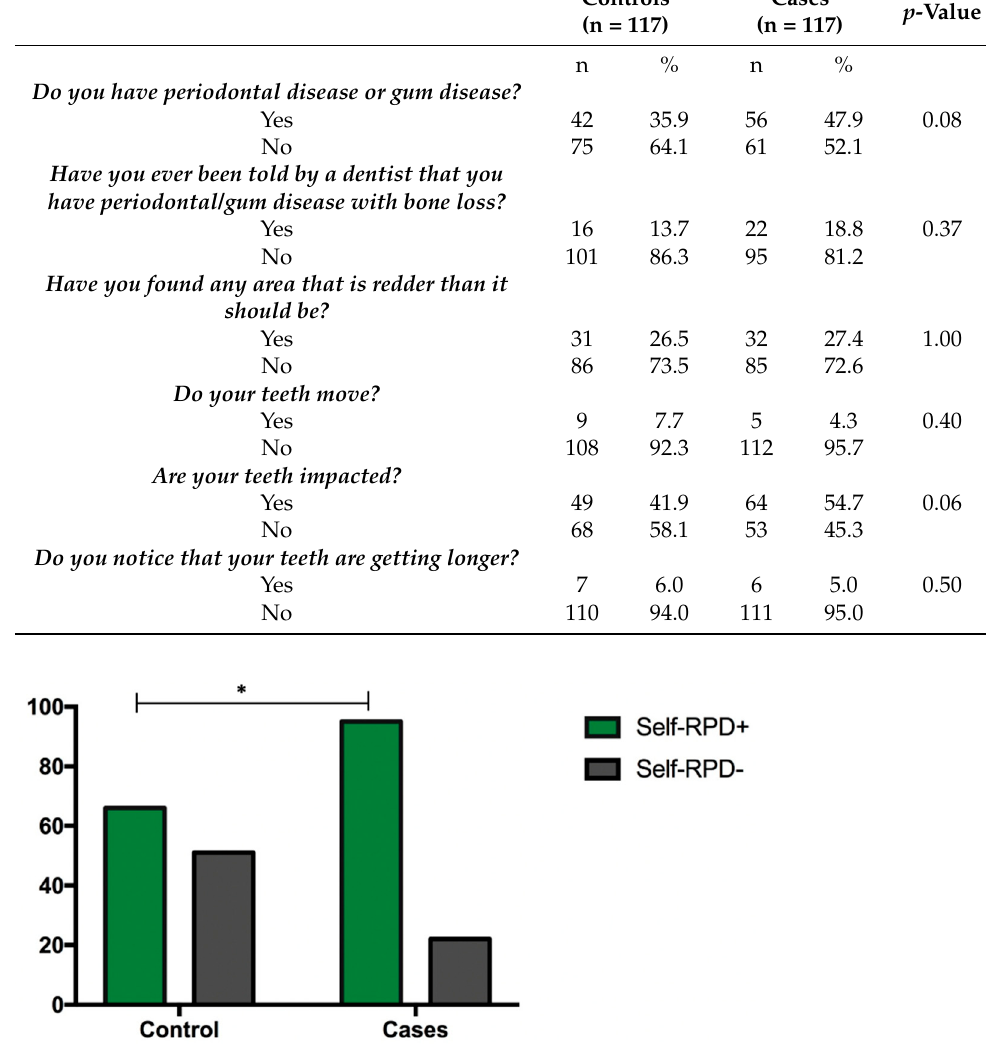
Figure 1. Self-RPD between the case and control groups. Control self-RPD positive (+): n = 66, 54.4%; Control self-RPD negative ( − ): n = 51,43.6%, Cases self-RPD positive (+): n = 95, 81.2%; Cases self-RPD negative ( − ).: n = 22, 18.8%. Statistics: χ 2 test. Abbreviations and symbols: Self-RPD: Self-reported periodontitis disease, * p value < 0.001.